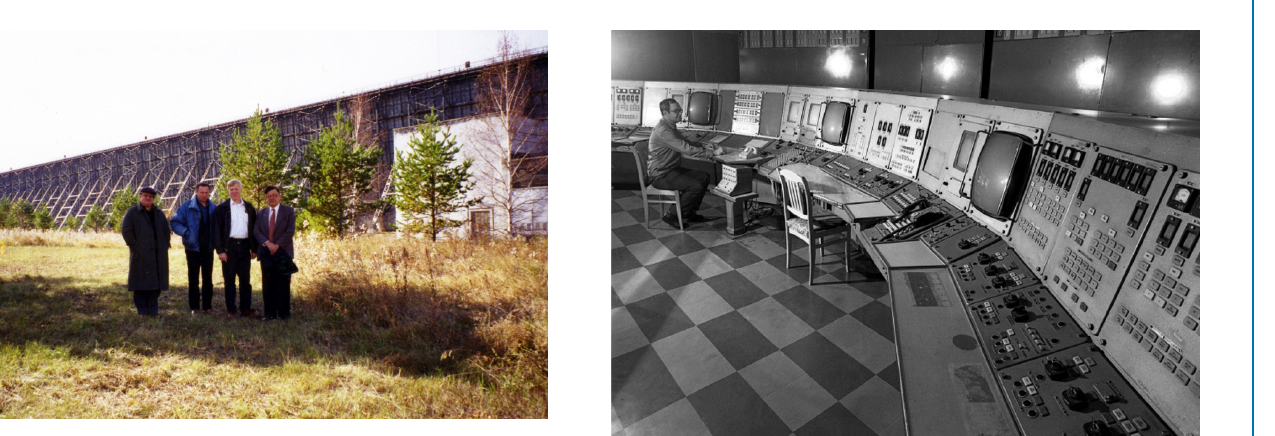
The extended slotted waveguide excitation system of each of the half-horns ensures the width of the antenna pattern (AP) along the big axis of about 0.5 ◦ . The ribbed slow-wave structure changes the wave phase velocity with the operat- ing frequency swaps. As a result, the distribution of initial phases on the emitting slots changes, i.e., the phase front in- clination, which ensures the AP scanning in a plane passing through the antenna big axis. At 154 MHz carrier frequency, emission is normal to the horn mouth plane. When the fre- quency changes in the range of 154–162 MHz, it causes the AP inclination of the exciting electromagnetic wave to move up to 30 ◦ away from the antenna aperture normal (Fig. 7). When excitation is fed to the antenna half-horn alternately from the opposite ends of the waveguide, the full angle of scanning is ± 30 ◦ relative to the antenna aperture normal. In the rolling plane (along the antenna short axis), the AP of each of the two independent sections of the antenna system is ∼ 20 ◦ wide. The radar cumulative AP is formed by